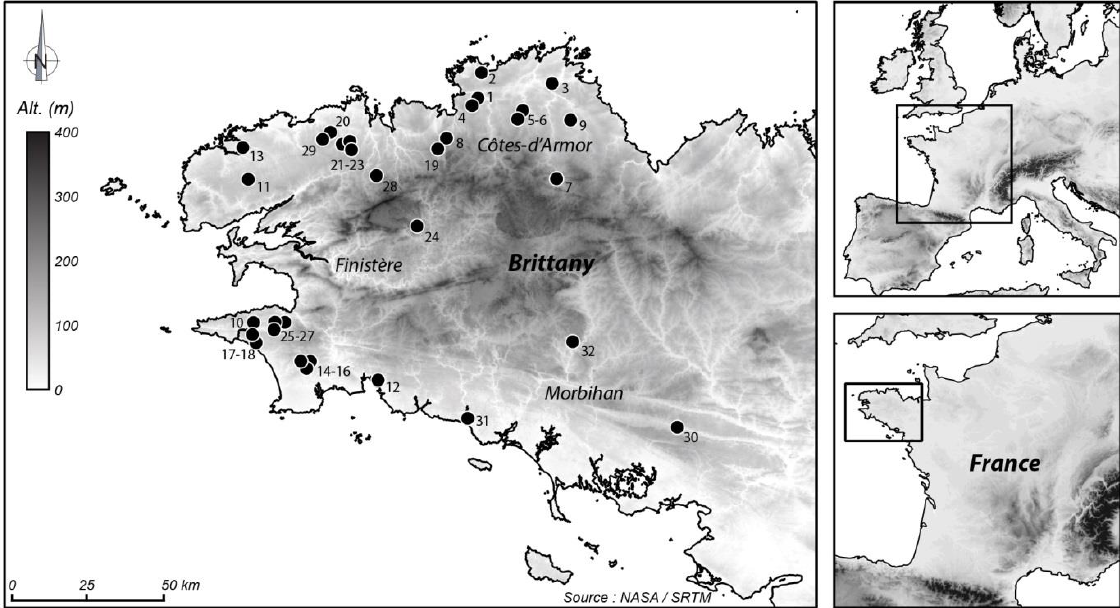
Figure 1. Distribution map of the Early Bronze Age graves including Armorican arrowheads in Brittany (mapping C. Nicolas). Côtes-d’Armor: 1. La Motta, Lannion; 2. Crec'h-Perros, Perros-Guirec; 3. Mouden-Bras, Pleudaniel; 4. Rumédon, Ploumiliau; 5. Tossen-Kergourognon, Prat; 6. Tossen-Rugouec, Prat; 7. Brun-Bras, Saint-Adrien; 8. Porz-ar-Saoz, Trémel; 9. Tossen-Maharit, Trévérec; Finistère: 10. Kerodou, Beuzec-Cap-Sizun; 11. Coatanéa, Bourg-Blanc; 12. Le Rhun, Concarneau; 13. Prat-ar-Simon-Pella, Lannilis; 14. Cosmaner, Plonéour-Lanvern; 15. Fao-Youen, Plonéour-Lanvern; 16. Kerhué-Bras, Plonéour-Lanvern; 17. Kersandy, Plouhinec; 18. Lescongar, Plouhinec; 19. Cazin, Plouigneau; 20. Goarillac'h, Plounévez-Lochrist; 21. Kernonen, Plouvorn; 22. Keruzoret, Plouvorn; 23. Lambader (?), Plouvorn; 24. Kerguévarec, Plouyé; 25. Kerlivit 2, Pouldergat; 26. Kervini Nord, Poullan-sur-Mer; 27. Kervini Sud, Poullan-sur-Mer; 28. Limbabu, Saint- Thégonnec; 29. Graeoc 2, Saint-Vougay; Morbihan: 30. Coët-er-Garf, Elven; 31. Cruguel, Guidel; 32. Saint- Fiacre,